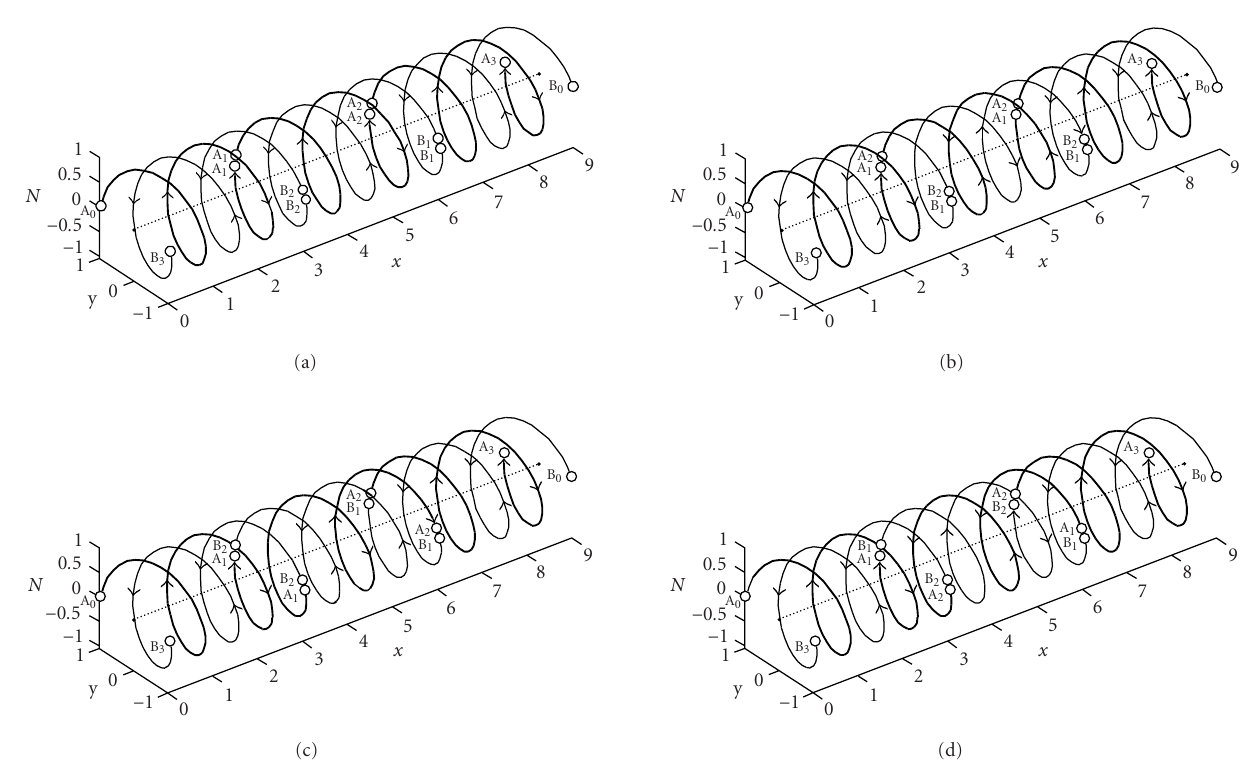
Figure 2: Schematic representations of the direction reversal of a DNA segment. (a) Initial state in which the two antiparallel strands have all the marked segments ordered in the 5 (cid:2) to 3 (cid:2) direction, indicated by arrows. (b) Hypothetic reversal of the middle segment without the switching of the strands. (c) Hypothetic switching of strands for the middle segment without its reversal. (d) Direction reversal and strand switching for the middle segment. The 5 (cid:2) to 3 (cid:2) alignment condition is violated in cases (b) and (c) but reestablished in (d).